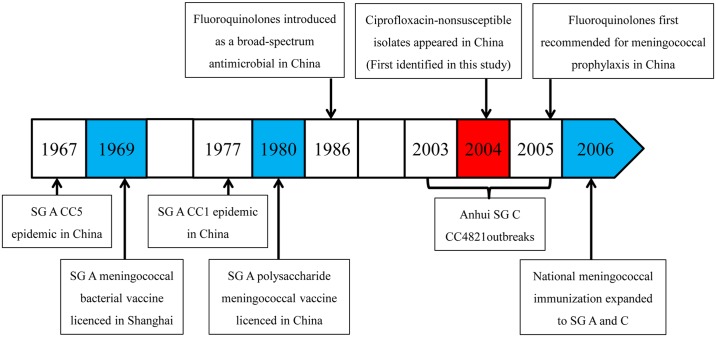
Timeline for the introduction of fluroquinolones and vaccines, and clonal waves of N. meningitidis in China.SG, serogroup.